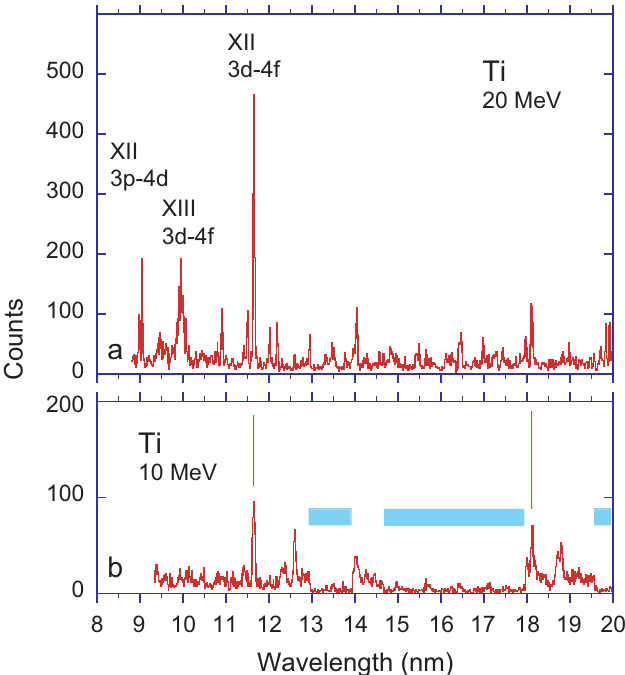
Figure 4. Beam–foil spectra of Ti recorded at ion beam energies of 20 MeV ( a ) and 10 MeV ( b ), respectively. Grating 600 L/mm, line width (FWHM) 0.038 nm in ( a ) and 0.06 nm in ( b ). The strongest lines are identified by the spectrum number. For the charge state distributions, see the legend for Figure 1. The light blue horizontal bars mark ranges of data recording with a reduced ion beam charge preset per channel.